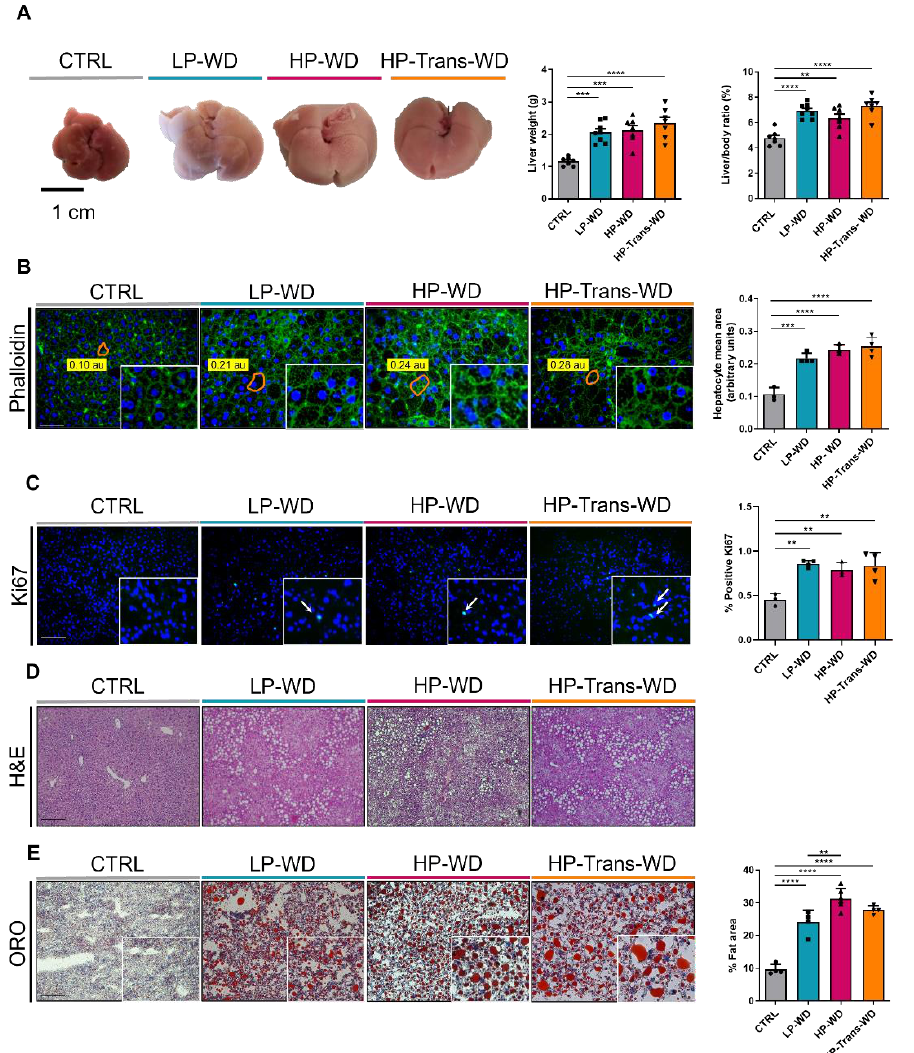
Figure 2. WD feeding leads to hepatomegaly and steatosis. ( A ) Left: Liver macroscopic images after 14 weeks of feeding. Middle: Liver weight (g) (n = 7–8). Right: Liver weight–to-BW ratio (%) (n = 7–8). ( B ) Representative phalloidin-stained liver images and size of hepatocytes in phalloidin-stained liver pictures quantified by ImageJ software. Scale bar = 100 μm (n = 3 – 4). ( C ) Ki-67 liver IF staining after 14 weeks of feeding. Positive proliferating cells are stained in green and indicated by arrows. Nuclei are stained in blue using DAPI as a counterstain. Scale bar = 100 μm (n = 3 – 4). ( D ) H and representative images. Scale bar = 100 μm. (n= 7 – 9). ( E ) Illustrative ORO-stained liver sections. Scale bar = 100 μm. Quantification of ORO -stained area (n = 4 – 6). ** p < 0.01, *** p < 0.001; **** p < 0.0001.